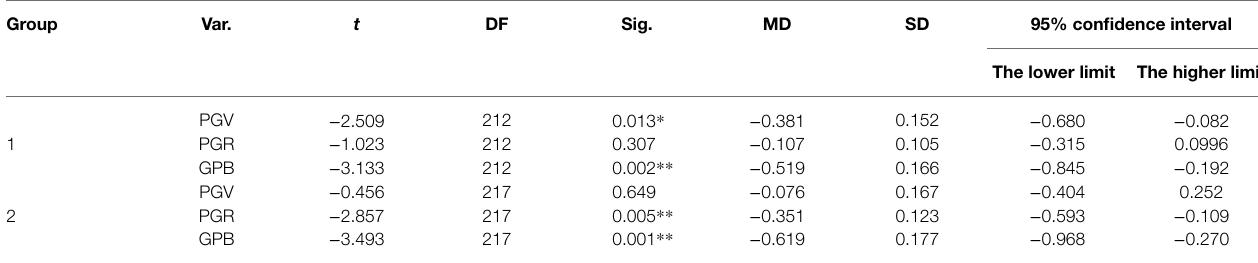
TABLE 3 | Variables’ independent sample T test.